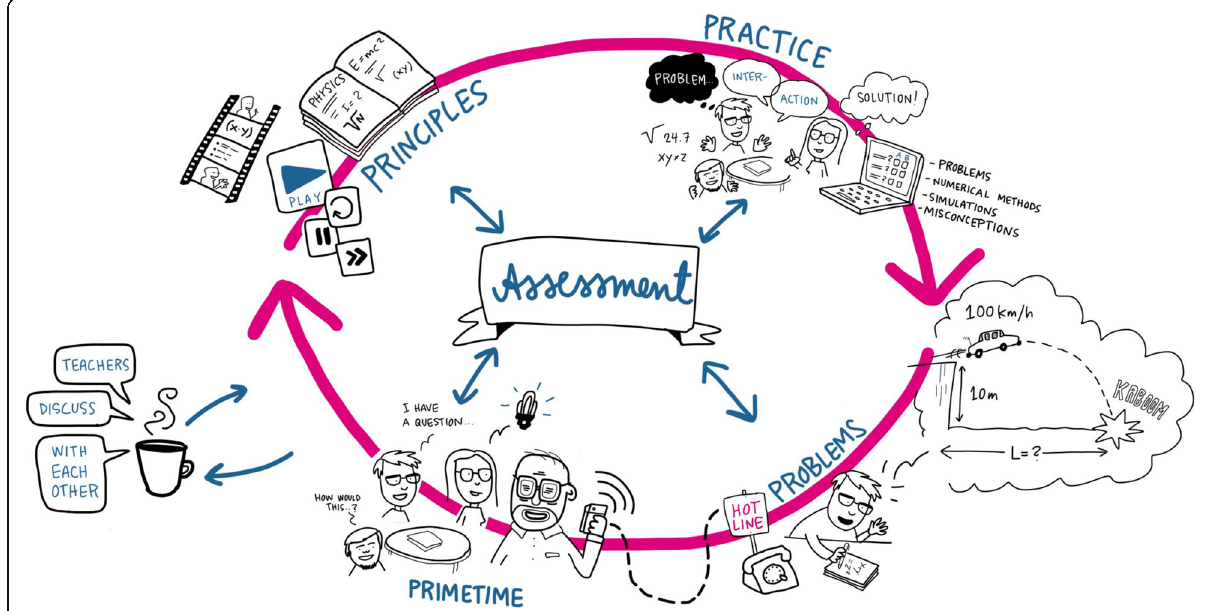
Fig. 2 Primetime learning model with the four-step study process: principles, practice, problems, and primetime. Formative assessment underlies the entire process and motivates students to perform activities that also directly affect the grade. This drawing is a succinct summary of the primetime model (drawing courtesy of Linda